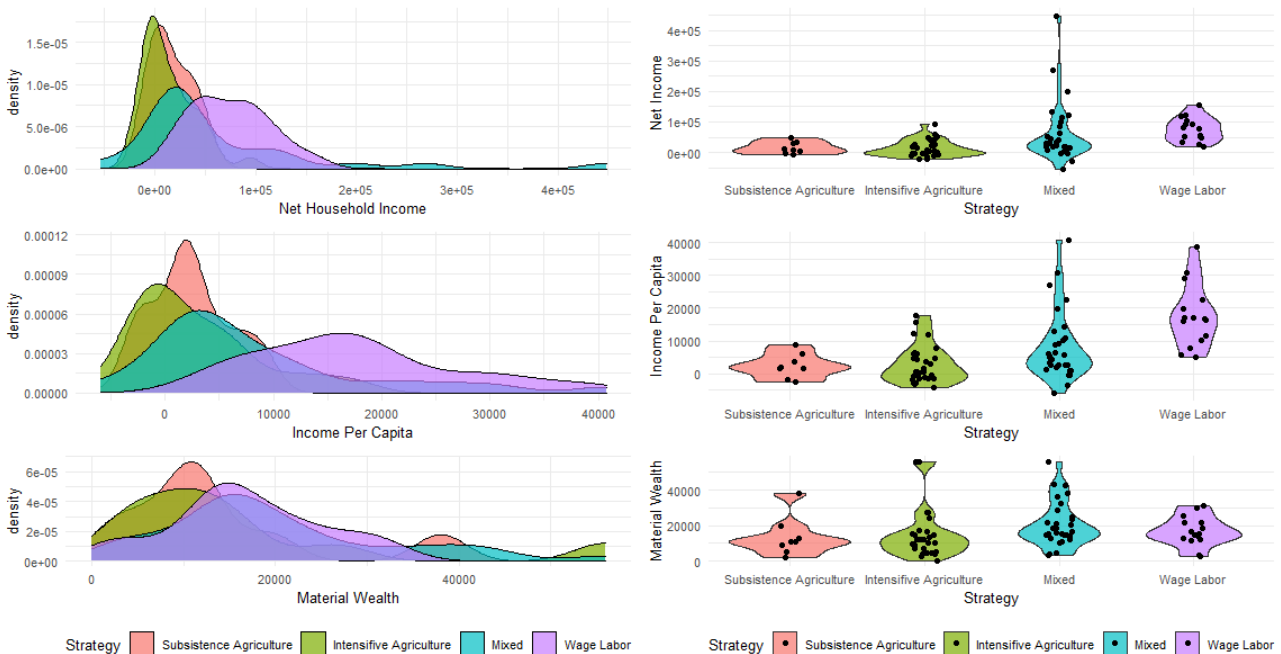
Figure 2. Distribution of household income and wealth variables by economic strategy.